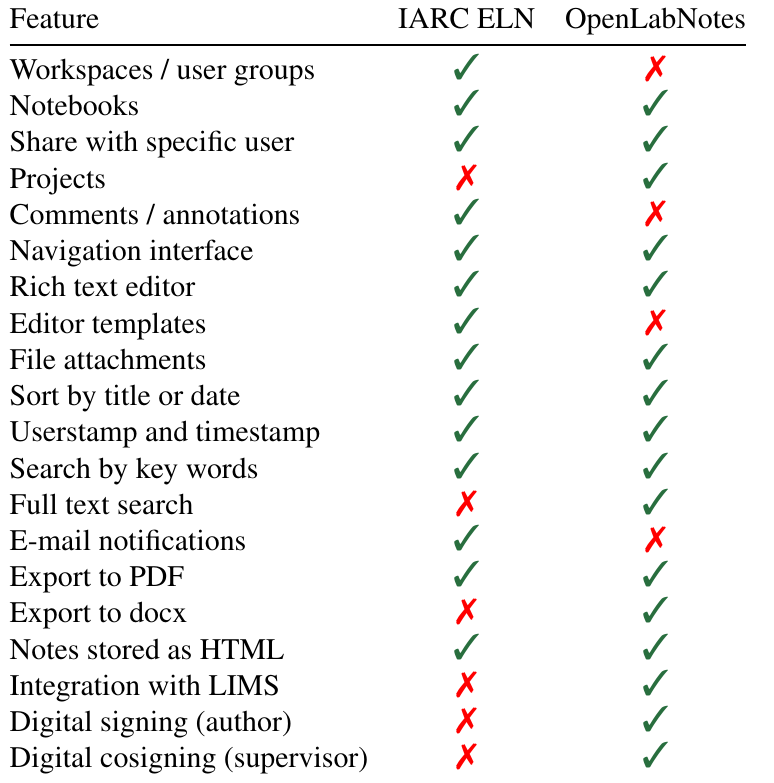
Table 1: Feature comparison between the IARC ELN and